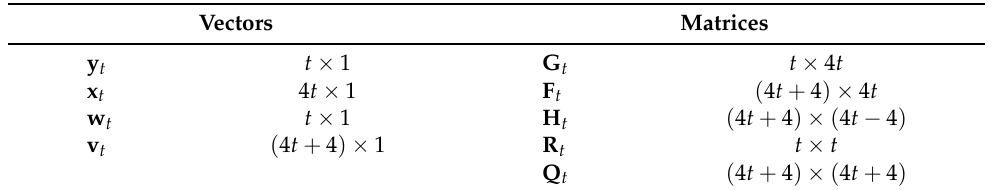
4 t × 4 t × ( 4 t 4 ) × − t × ( 4 t + 4 ×